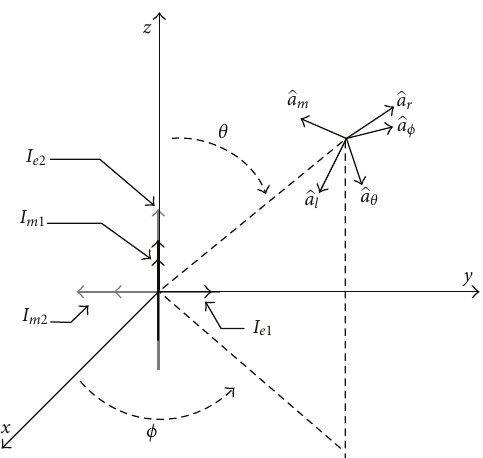
Figure 2: Spherical coordinate system for electric fields radiating form orthogonal Huygens